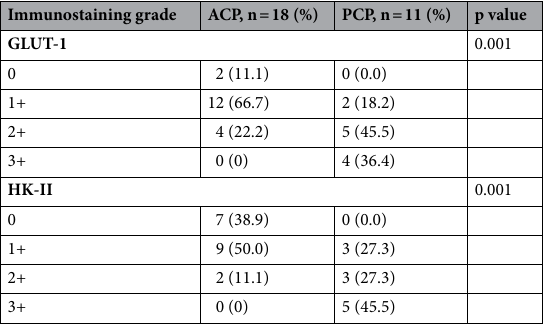
Table 2. Immunostaining score for anti-GLUT-1 and